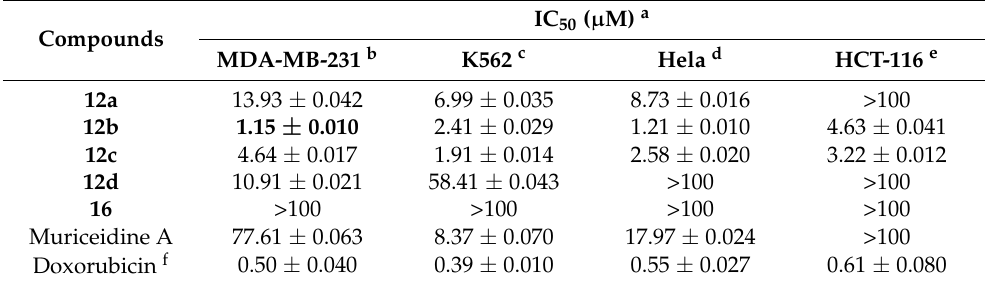
Table 1. Antitumor activity of target compounds 12a – d and 16 against four human cancer cell